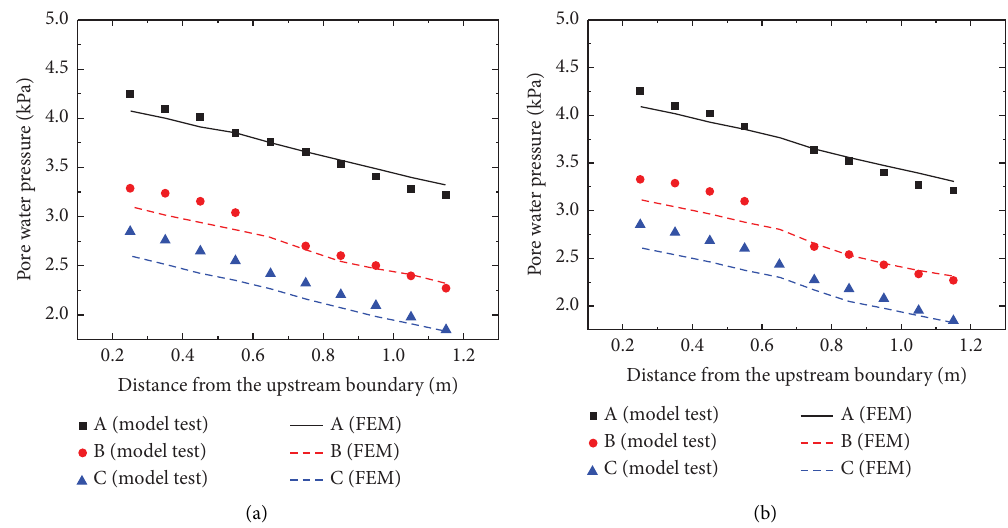
Figure 6: Comparison of the pore water pressures from the FEM and physical model test results. (a) b � 0.2m. (b) b � 0.4m.